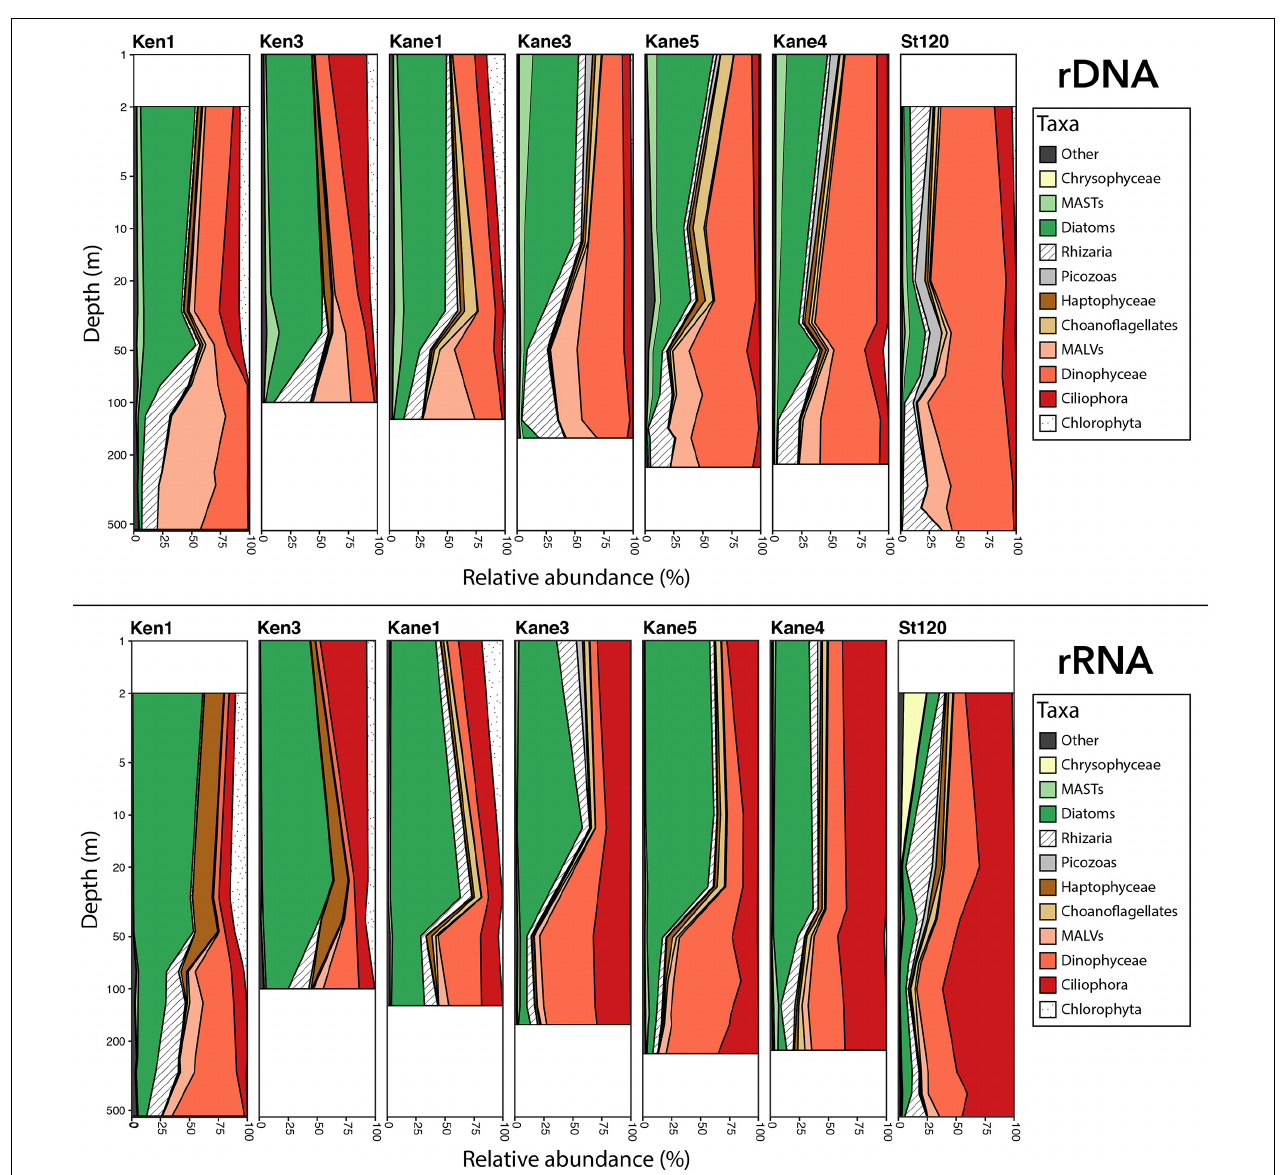
FIGURE 5 | Depth profiles showing the relative proportion of the dominant eukaryote major groups. Upper panel shows rDNA and lower panel shows rRNA. MASTs and MALVs are defined in the